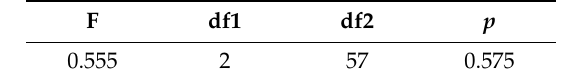
Table 3. Levene’s test for homogeneity of the group